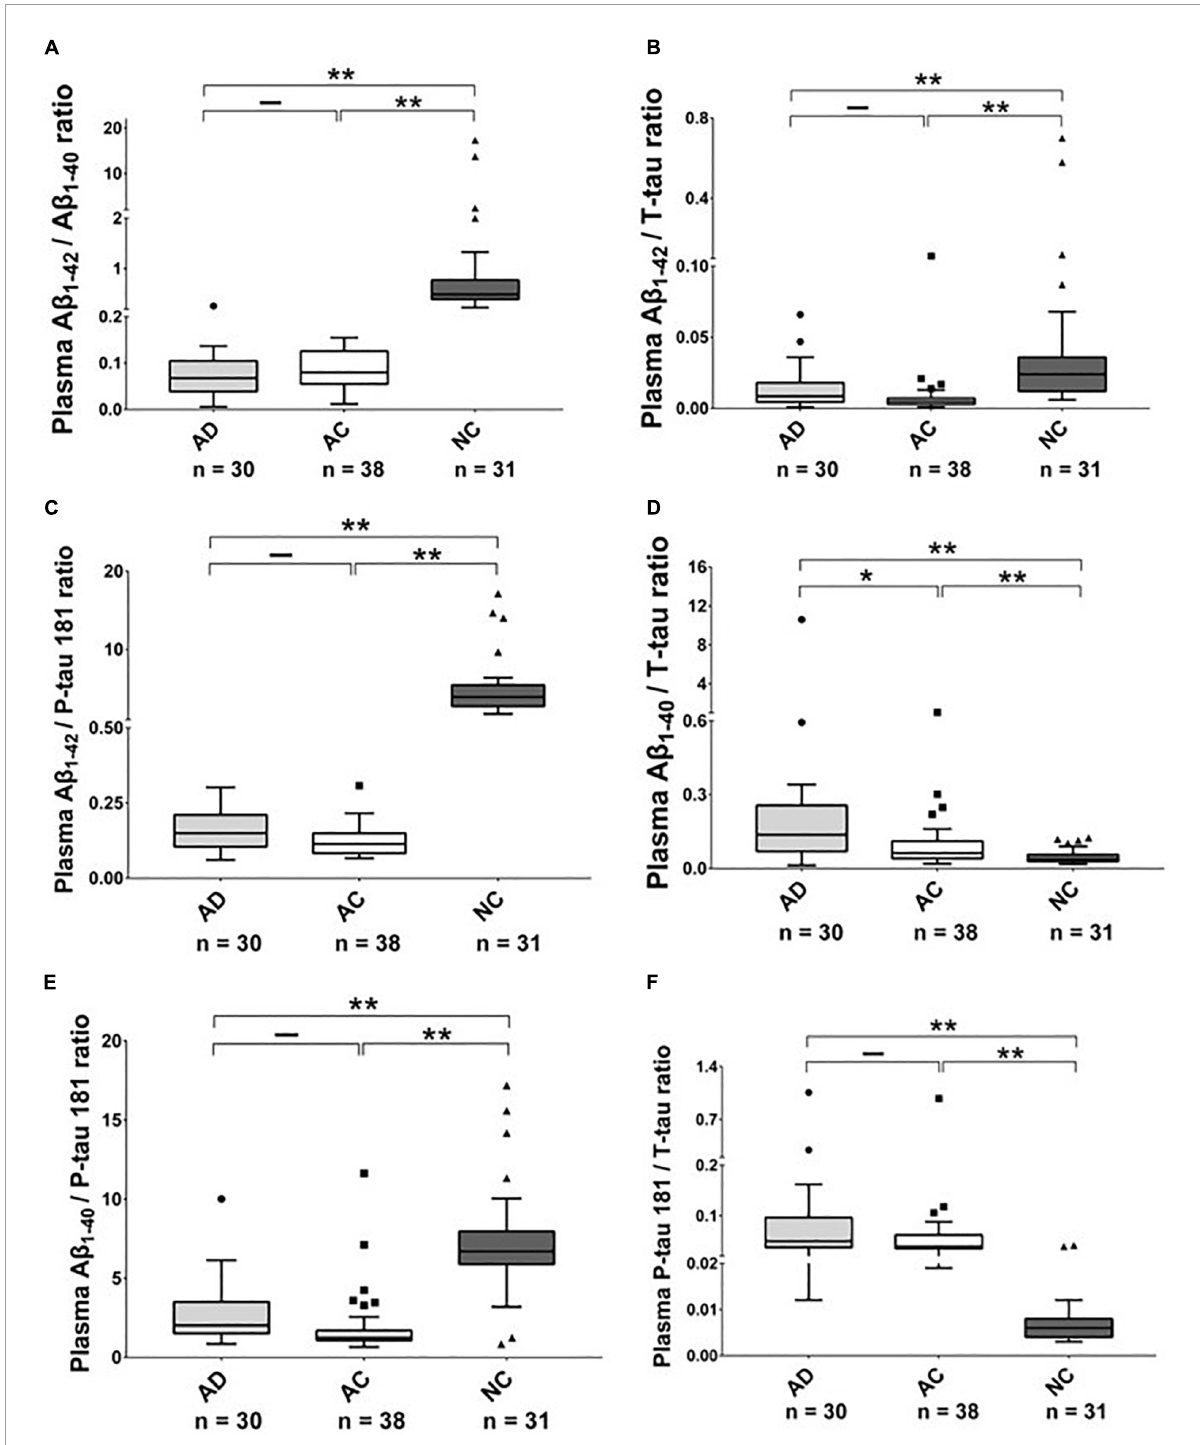
FIGURE2 The plasma protein ratios in Alzheimer’s disease (AD), Adult Children (AC), and Non-demented Control (NC) groups. Ratio (A) A β 1 - 42 /A β 1 - 40 , (B) A β 1 - 42 / T-tau, (C) A β 1 - 42 /P-tau 181, (D) A β 1 - 40 /T-tau, (E) A β 1 - 40 /P-tau 181 and (F) P-tau 181/T-tau in these three groups were compared using the Kruskal–Wallis tests. The boxes show interquartile range, the horizontal lines are medians and the whiskers were plotted using the Tukey method. * p < 0.05, ** p <